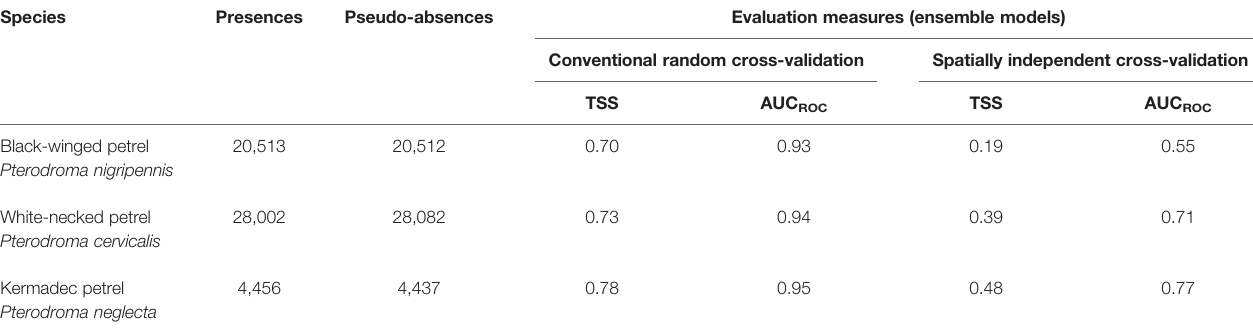
TABLE 4 | Number of presences and pseudo-absences used to build ensemble species distribution models (SDM) and the average values of fi vefold conventional random cross-validation and spatially independent cross-validation for the two calculated model evaluation measures including true skill statistic (TSS) and area under the receiver operating characteristic curve (AUC ROC